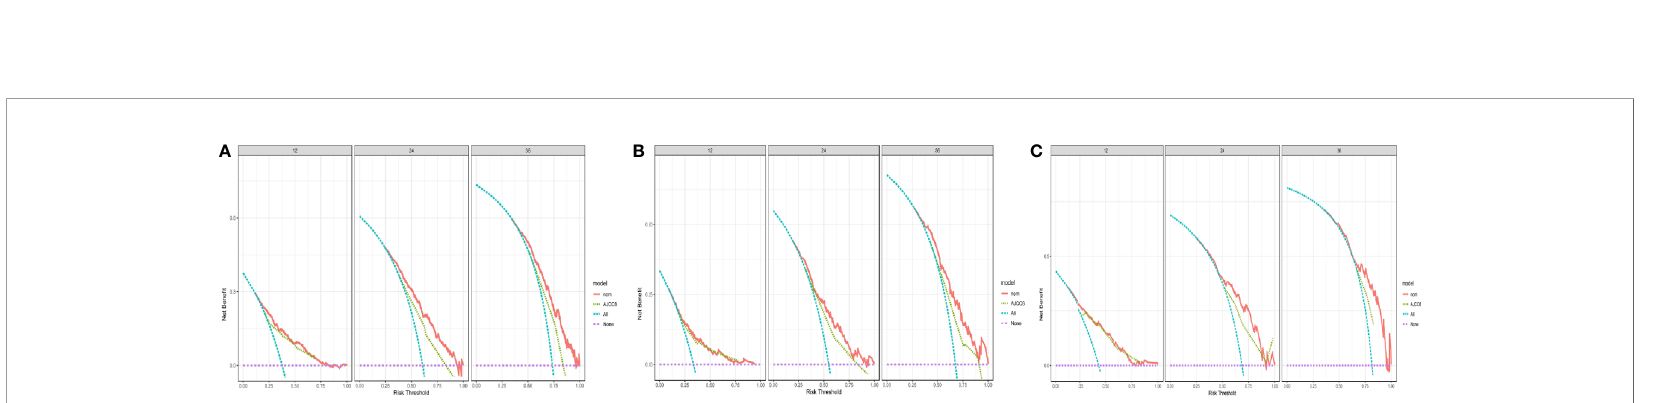
FIGURE 8 | Decision curve analysis and comparison of the nomograms with the 8 th AJCC stages. Decision curve analysis (DCA) of the nomograms for predicting (A) 1-, 2-, and 3-year survival in the PDAC group; (B) 1-, 2-, and 3-year survival in the PHC; and (C) 1-, 2-, and 3-year survival in the PBTC